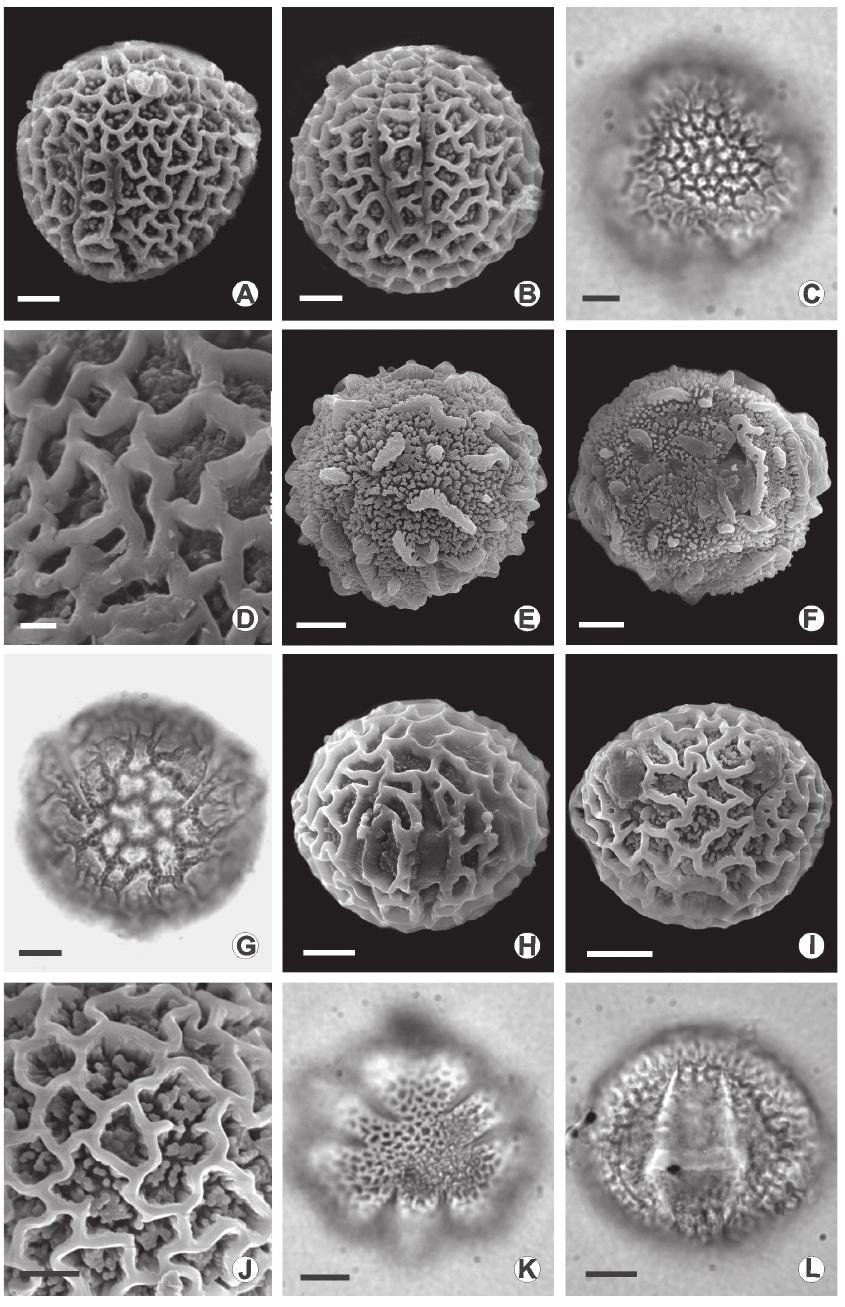
Figure 3. Photomicrographs and electron photomicrographs of pollen grains of the species of Passiflora . A, B Passiflora amoena C, D Passiflora fuchsiiflora E, F Passiflora jussieui G, H Passiflora ovata I, J Passiflora quelchii K, L Passiflora tessmannii A, C, E, G, K general aspect of polar view B, F, H, I, L general aspect of equa- torial view, D and J ornamentation detail. Scale bars: 10 µm ( C, E, F, G, H, I, K, L ); 5 µm ( A, B, J ); 1 µm ( D